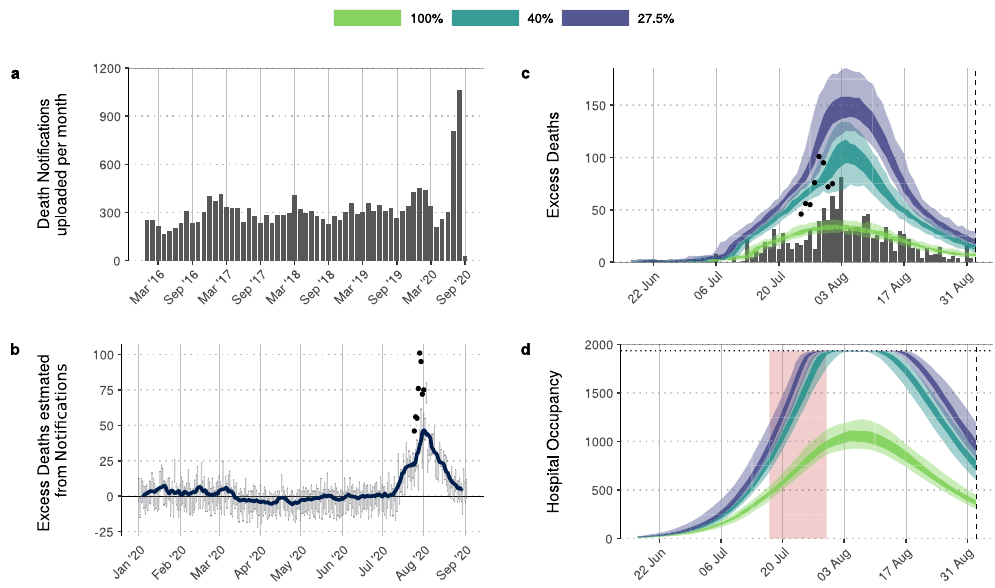
Fig. 2 Community-uploaded death noti fi cations in Damascus and the inferred epidemic trajectory. In ( a ) we show the number of obituary noti fi cation photos uploaded monthly to the community maintained ‘ Damascus Mortality ’ Facebook page revealing a substantial increase in July and August 2020. This is in contrast to the consistent monthly number of noti fi cations uploaded between 2016 and 2020. In ( b ), the daily inferred excess death noti fi cations are shown, with error bars showing the 95% CI ( n = 100) and the blue line indicating the weekly average excess deaths. In ( c ) model fi ts to the noti fi cation excess death data (vertical bars) are shown under different assumptions of the proportion of total COVID-19 deaths that are ascertained by the noti fi cation excess deaths. In both ( b , c ) the points show the government-reported excess deaths between 25 July and 1 August. The predicted hospital occupancy is shown in ( d ), with the hospital capacity for Damascus shown with a dashed horizontal line, with the 2-week period in which hospitals were reported to be fi rst at capacity shown shaded in red. In ( c , d ) the 50% and 95% CI are shown with dark and light shaded regions